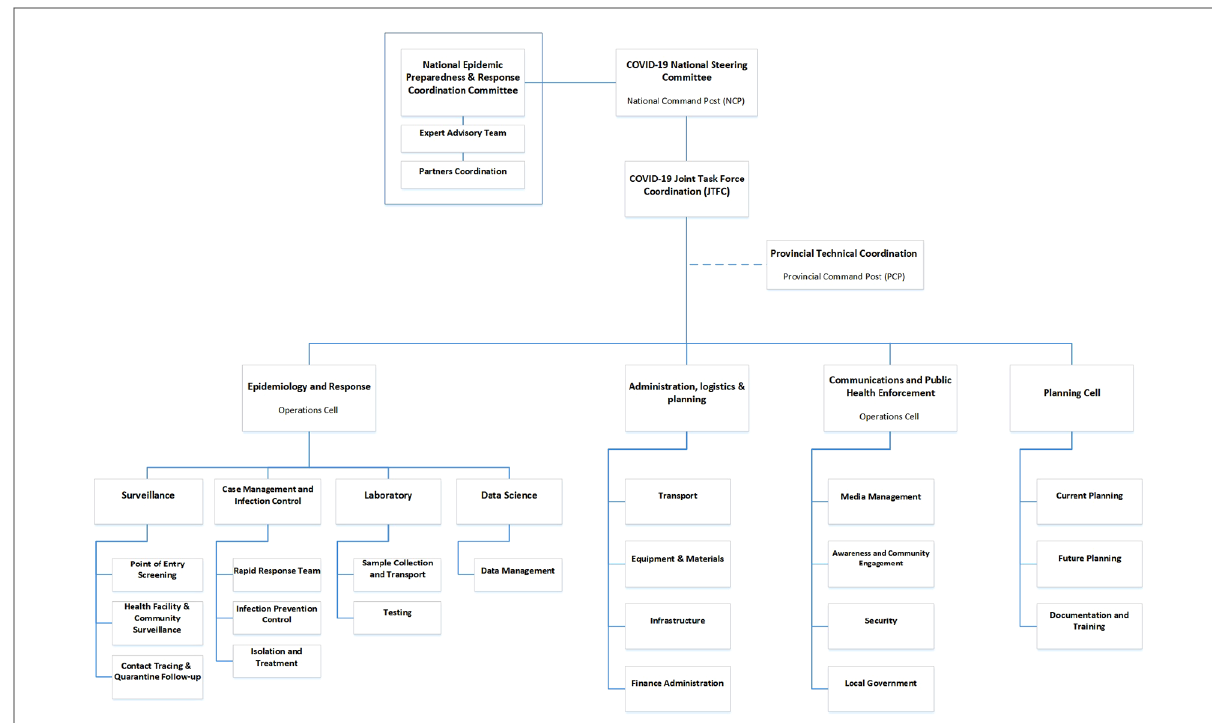
FIGURE 1 Structure Diagram of the COVID-19 Joint Task Force in Rwanda: This fi gure was adopted from